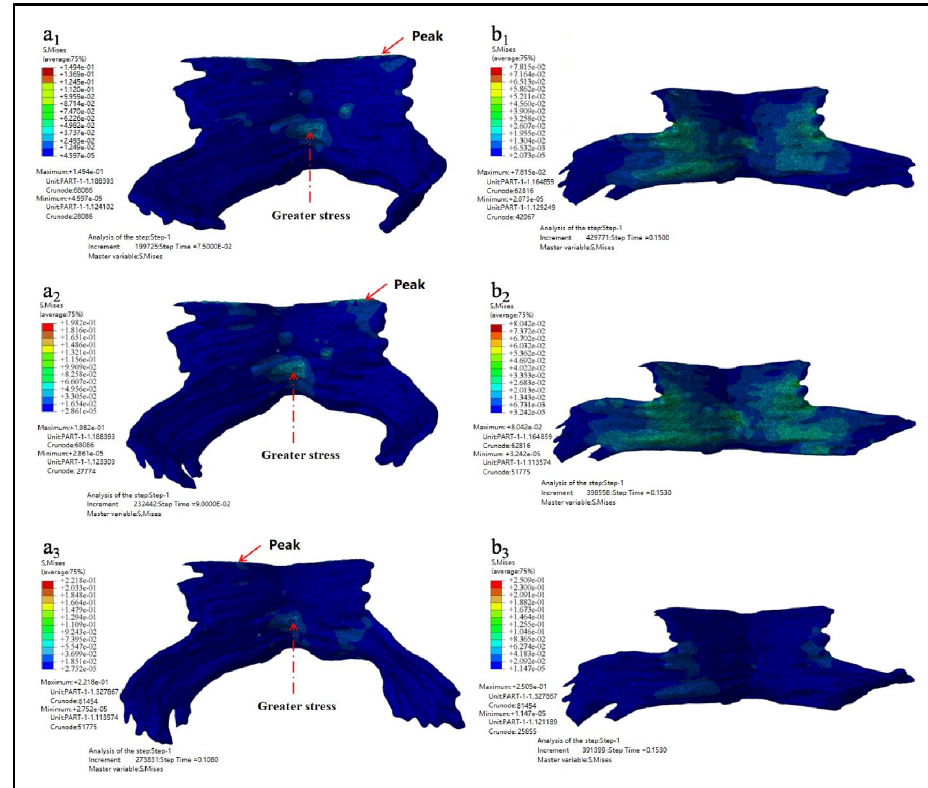
Figure 6. Equivalent stress nephogram. (a1–a3 show the equivalent stress nephogram of Models D80, D90, and D100 while b1–b3 show the equivalent stress nephogram of Models D80, D90, and D100 at simulation time of 0.15s)